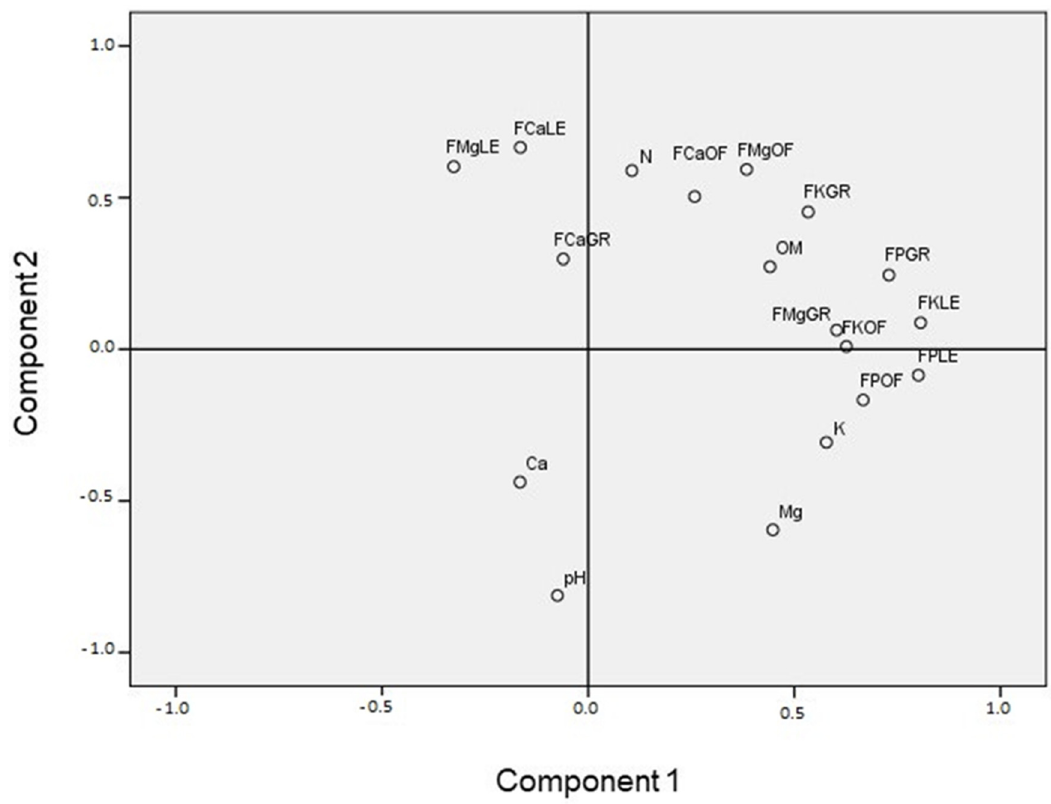
Figure 2. Plot of the principal component analysis with projection of the soil and foliar variables; component 1 as x axis and component 2 as y axis (44.2% of the total variance explained). FMgLE: foliar Mg in legumes; FCaLE: foliar Ca in legumes; FKLE: foliar K in legumes; FPLE: foliar P in legumes, FMgGR: foliar Mg in grasses; FCaGR: foliar Ca in grasses; FKGR: foliar K in grasses; FPGR: foliar P in grasses; FMgOF: foliar Mg in other families, MCaOF: foliar Ca in other families; FKOF: foliar K in other families; FPOF: foliar P in other families; OM: organic matter; N: total soil N; Ca, Mg, K: exchangeable Ca, Mg and K in the soil.